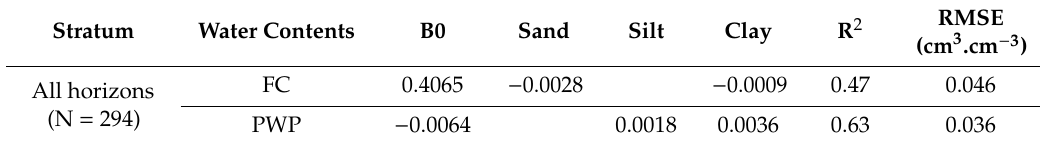
Table 1. Outcomes of the calibrated continuous pedotransfer functions (PTFs) for calculations of water contents at field capacity (FC) and at permanent wilting point